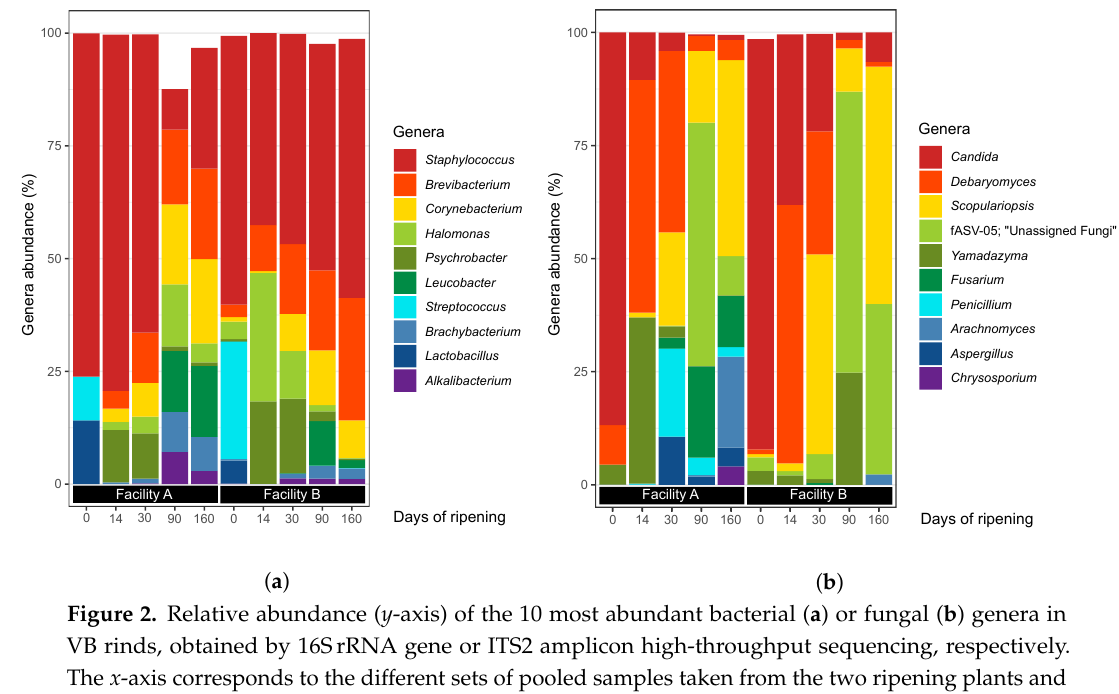
Figure 2. Relative abundance ( y -axis) of the 10 most abundant bacterial ( a ) or fungal ( b ) genera in VB rinds, obtained by 16SrRNA gene or ITS2 amplicon high-throughput sequencing, respectively. The x -axis corresponds to the different sets of pooled samples taken from the two ripening plants and at the 5 different ripening times (20 samples per plant and ripening